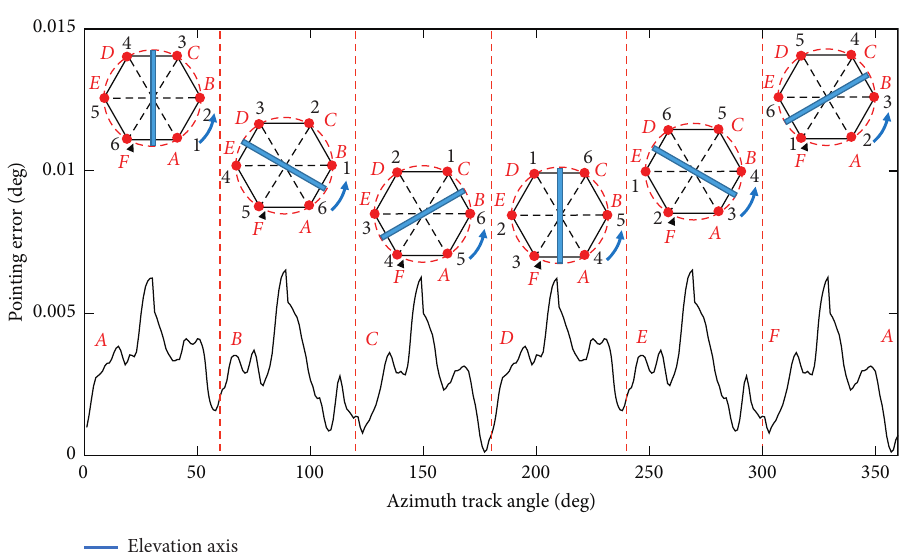
Figure 11: Telescope pointing error for the six-support-point case (Elevation angle is set to be 1